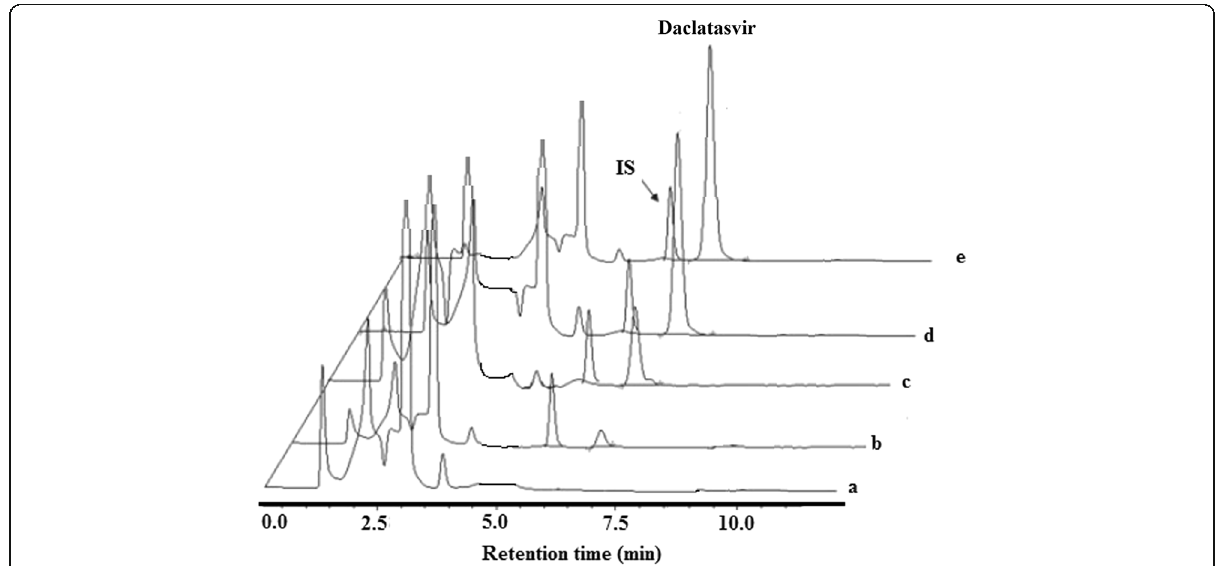
Fig. 4 Typical representative chromatograms of IL-DLLME extracts of rat serum spiked with daclatasvir at different concentrations a blank, b 0.1, c 1.0, d 5.0, and e 10.0 ppm